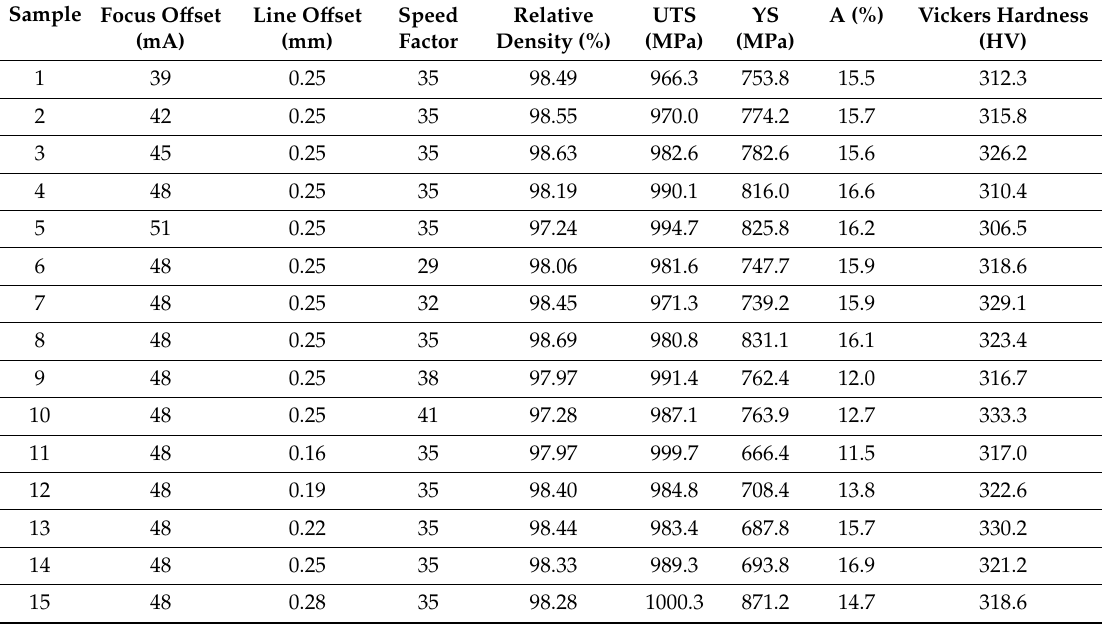
Table 3. Process parameters and properties of Ti-6Al-4V alloy produced by electron beam melting